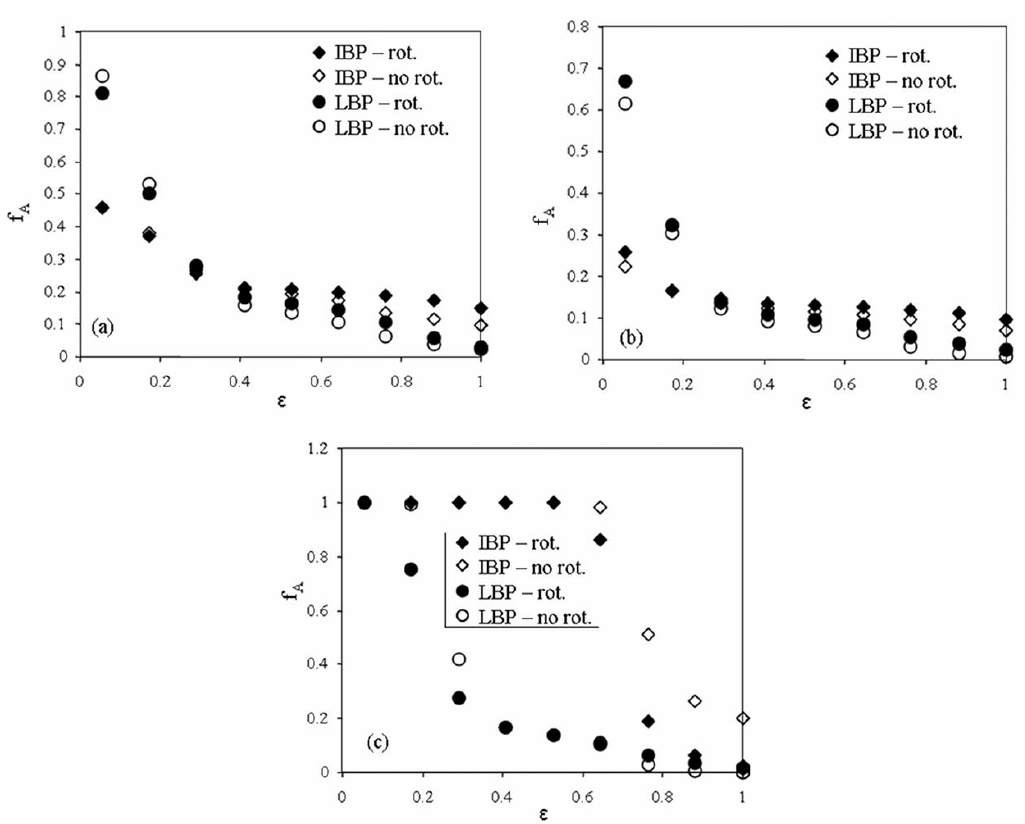
Figure 8. Evolution of the fractional area f A vs. the normalized permittivity threshold for the 2 image reconstruction methods, taking into account rotation (4 positions) or no rotation (1 position). ( a ) Settled layer #1, ( b ) settled layer #2, ( c ) slug #4.